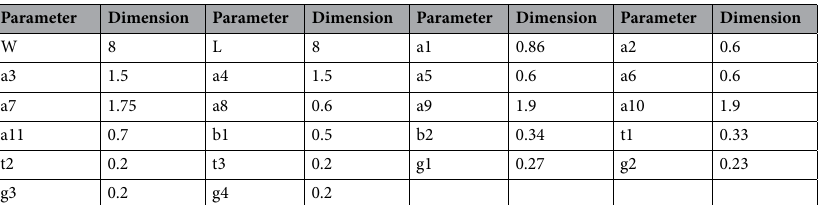
Table 1. Specifications of the various parameters of the proposed MTM unit cell.